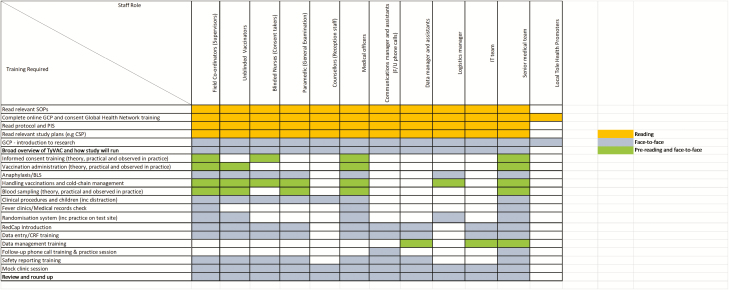
Staff training matrix. Training required according to staff role, prior to the delivery of TyVAC-Nepal. Abbreviations: BLS, basic life support; CRF, case report form; CSP, Clinical Study Plan; F/U, follow-up; GCP, good clinical practice; IT, information technology; PIS, participant information sheet; SOP, standard operating procedure; TyVAC, Typhoid Vaccine Acceleration Consortium.